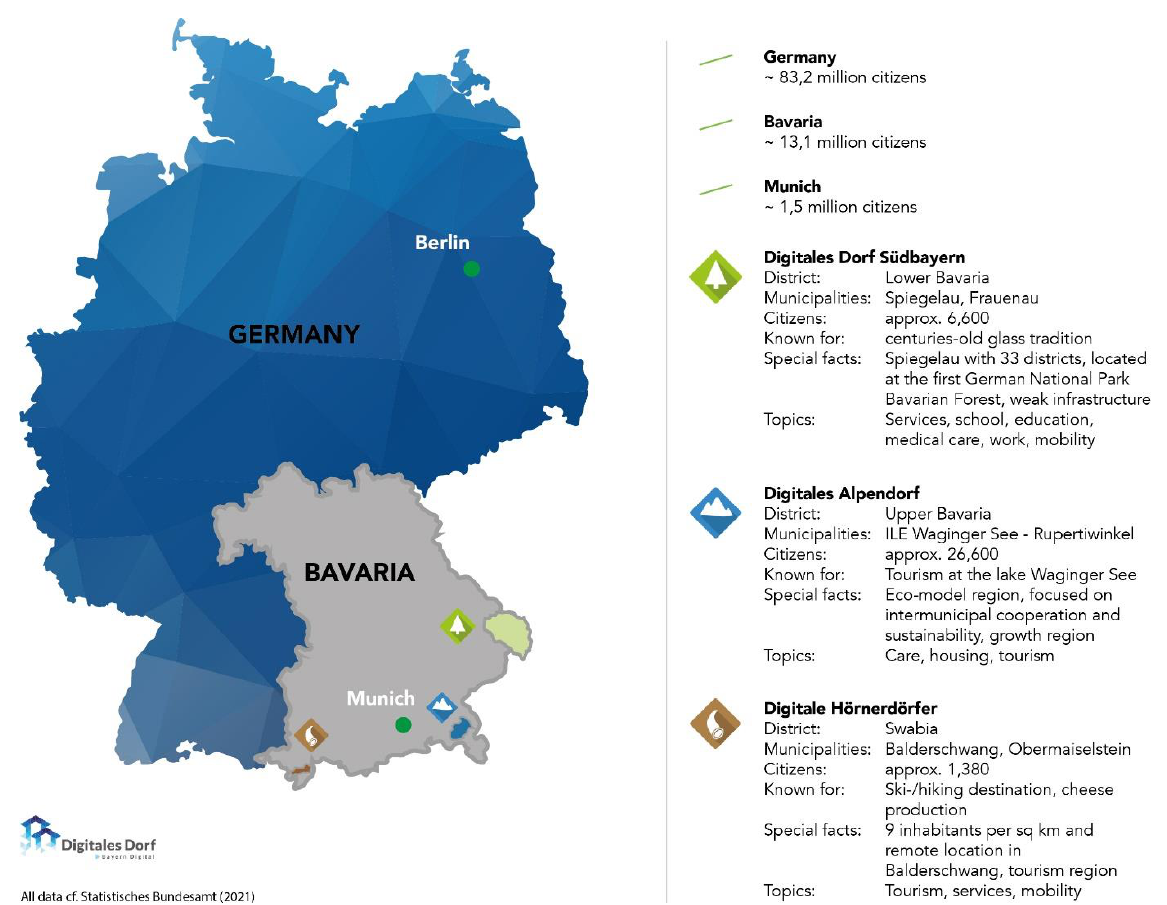
Figure 2: Location and short description of the pilot areas mentored by Deggendorf Institute of